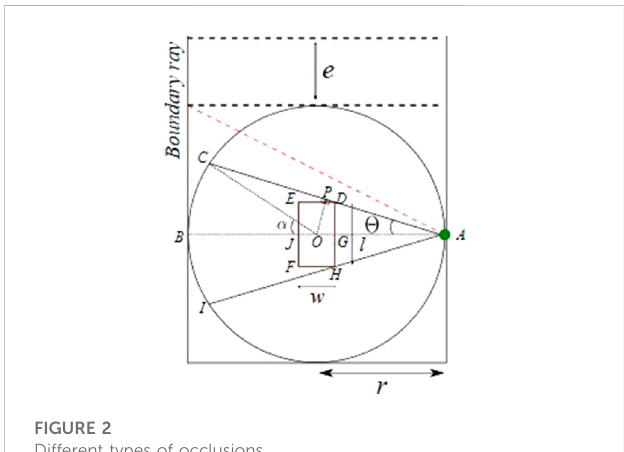
FIGURE 2 Different types of